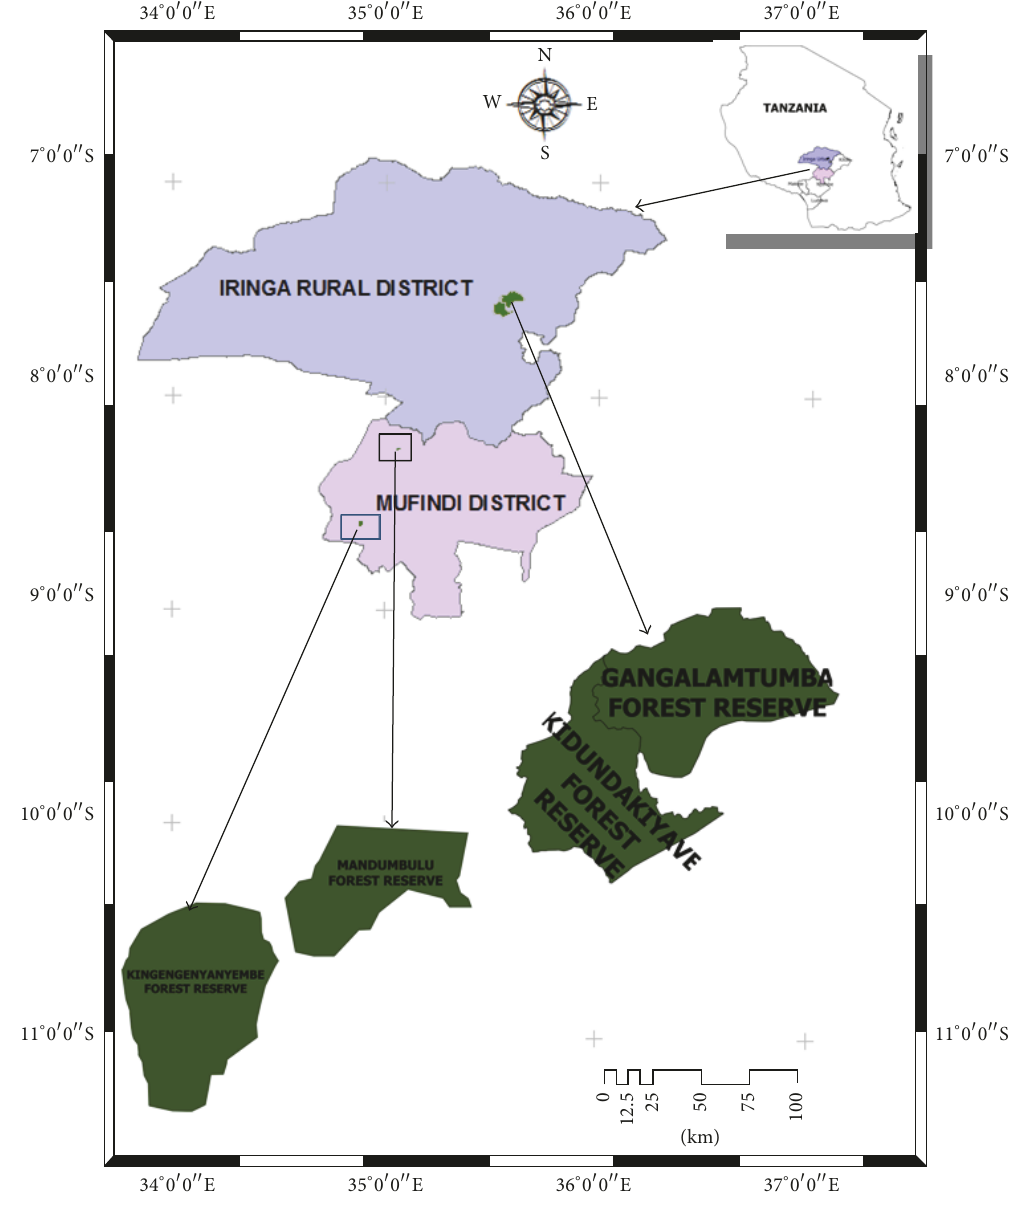
Figure 1: Geographical location of study districts and respective studied forest reserves of Southern Highlands of